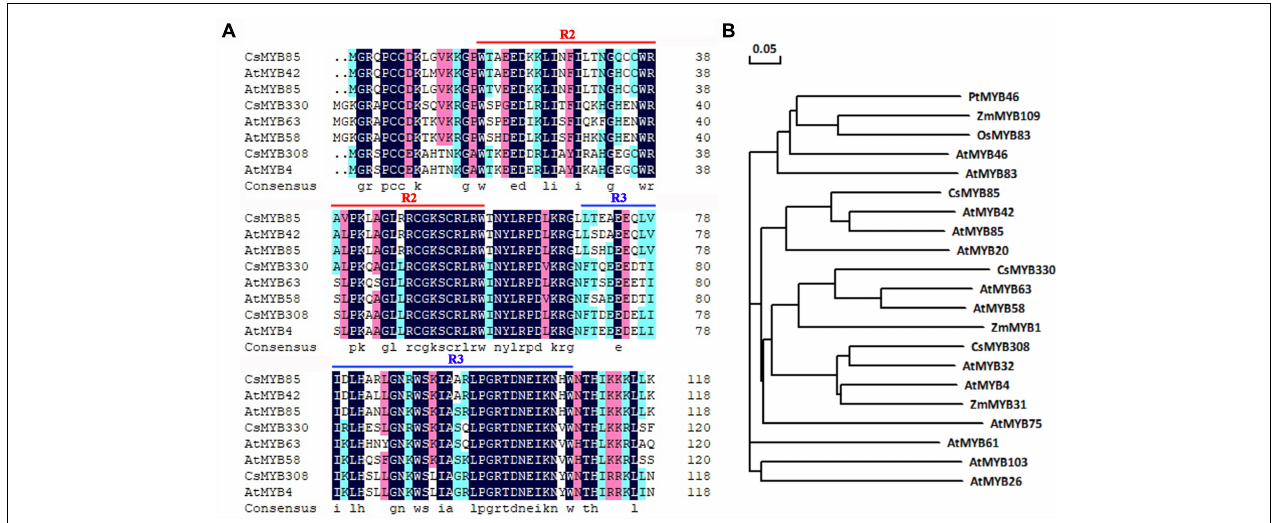
FIGURE 1 | CsMYB85 sequence and phylogenetic analysis. (A) Alignment of the conserved R2R3 domains in CsMYB85 with those in AtMYB42, AtMYB85, AtMYB58, AtMYB63, AtMYB4, CsMYB330, and CsMYB308. (B) Phylogenetic tree for CsMYB85 and MYB transcription factors from other plants: Populus trichocarpa , Arabidopsis thaliana , Zea mays, and Oryza sativa . The accession numbers of the transcription factor proteins are as follows: PtMYB46 (XP_024465368.1), ZmMYB109 (NP_001241859.1), OsMYB83 (XP_015619488.1), AtMYB46 (AT5G12870), AtMYB83 (At3g08500), CsMYB85